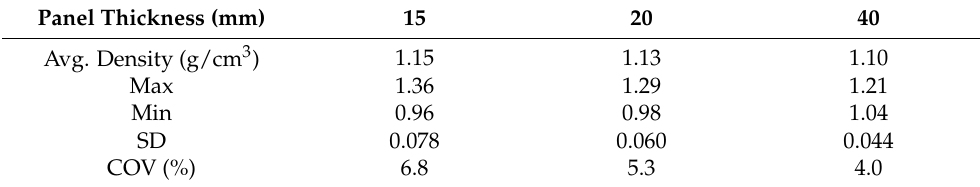
Table 3. Average density and variability for each panel thickness (50 × 50-mm 2